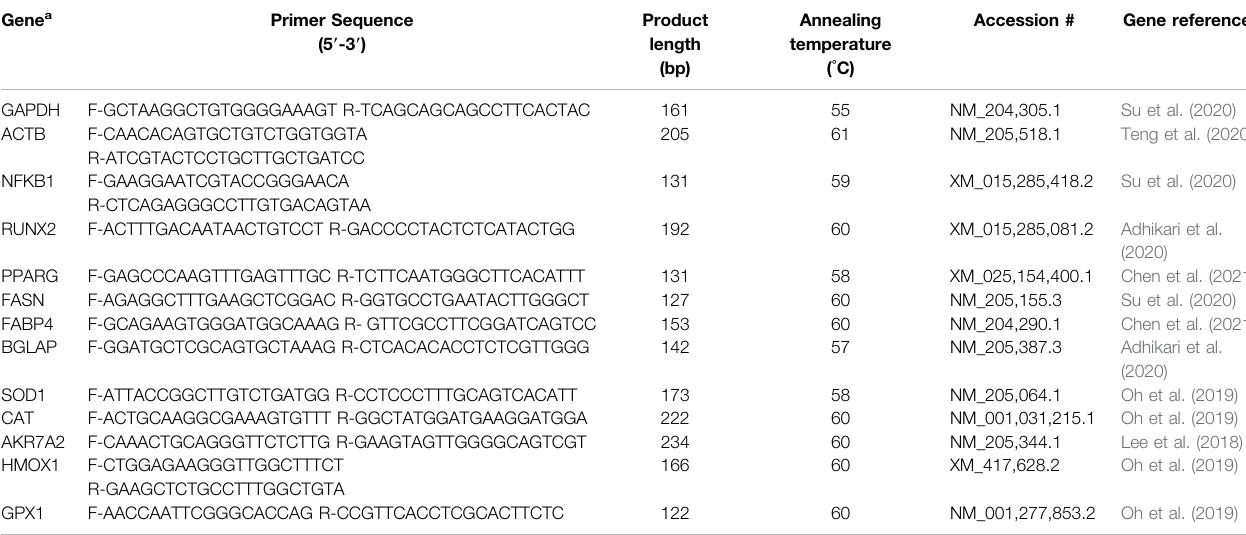
TABLE 3 | Nucleotide sequences of the primers used for real-time